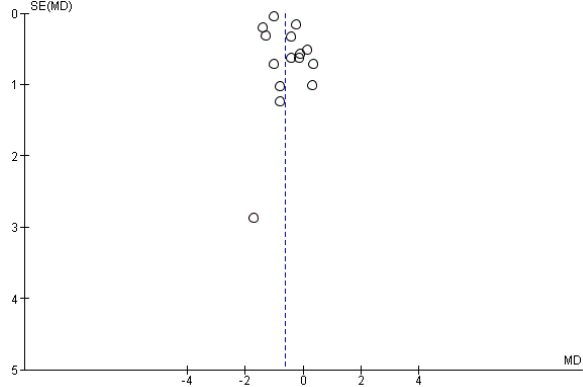
Figure 6. Funnel plot showing study precision against the mean differences effect estimate with 95% confidence intervals for C -reactive protein. SE = Standard error.